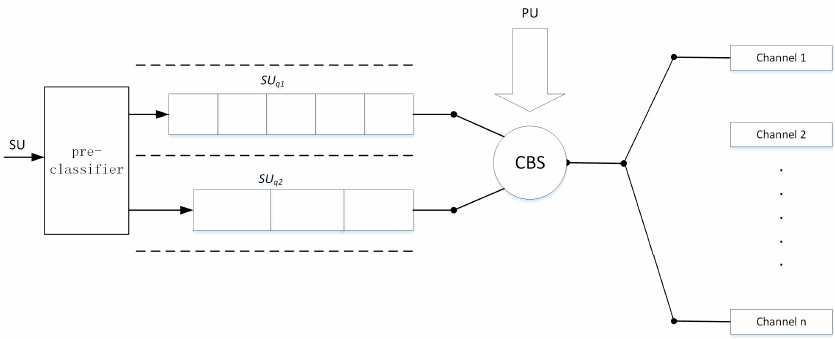
Figure 3. Queuing model with two queues and multiple servers.